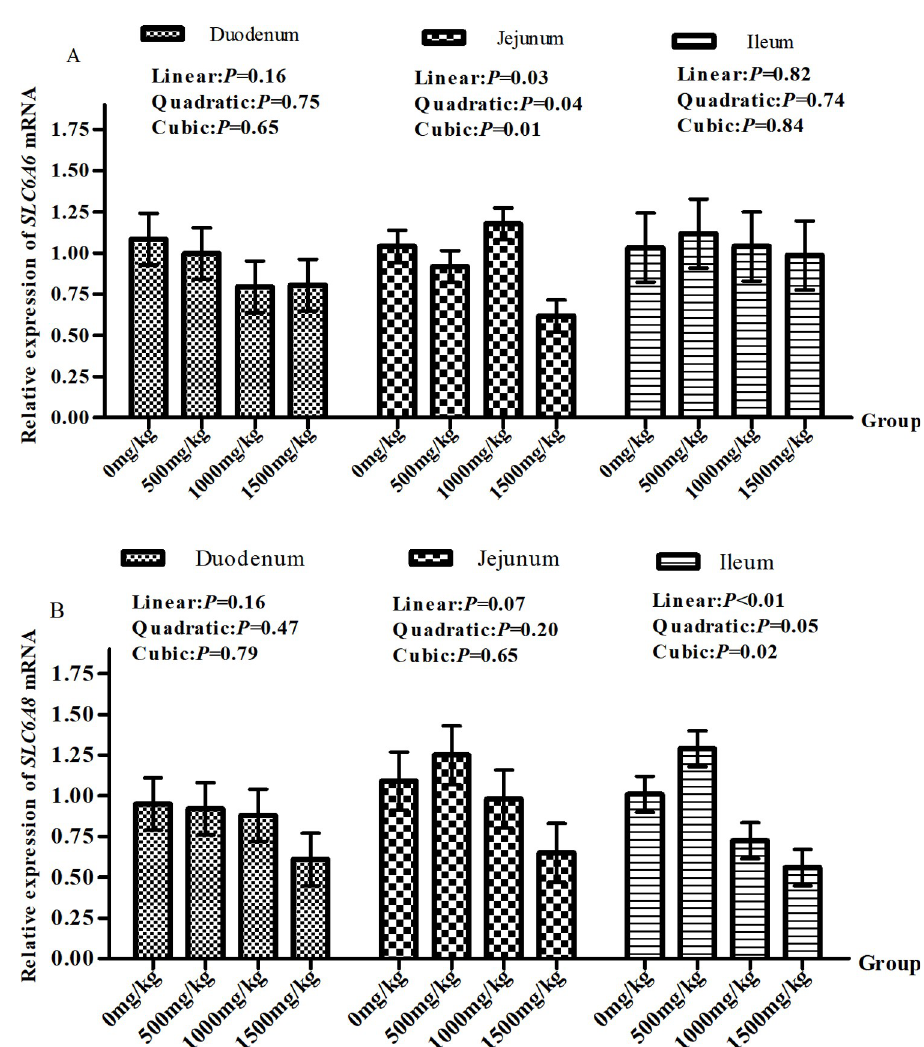
Fig 2. The mRNA expression levels of SLC6A6 (A) & SLC6A8 (B) in lambs small intestinal segment mucosa. The mRNA expression levels of SLC6A6 (A) & SLC6A8 (B) in lambs small intestinal segment mucosa following a diet supplemented with 500, 1000, 1500 mg/kg DM GAA or no supplementation at 4 h after feeding. Values are least squares means ± SE ( n = 5